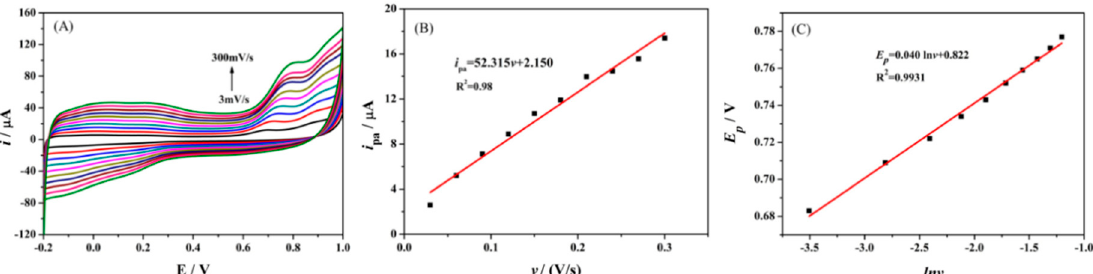
Figure 5. ( A ) Cyclic voltammograms of oxytetracycline on Ta 2 O 5 -ErGO/GCE at different scanning rates; ( B ) relationship between oxidation peak current ( i pa ) and scanning rate (v); ( C ) the oxidation potentials ( E p ) are linearly proportional to the Napierian logarithm of scan rate (ln v ) (the current values have been baseline-corrected).